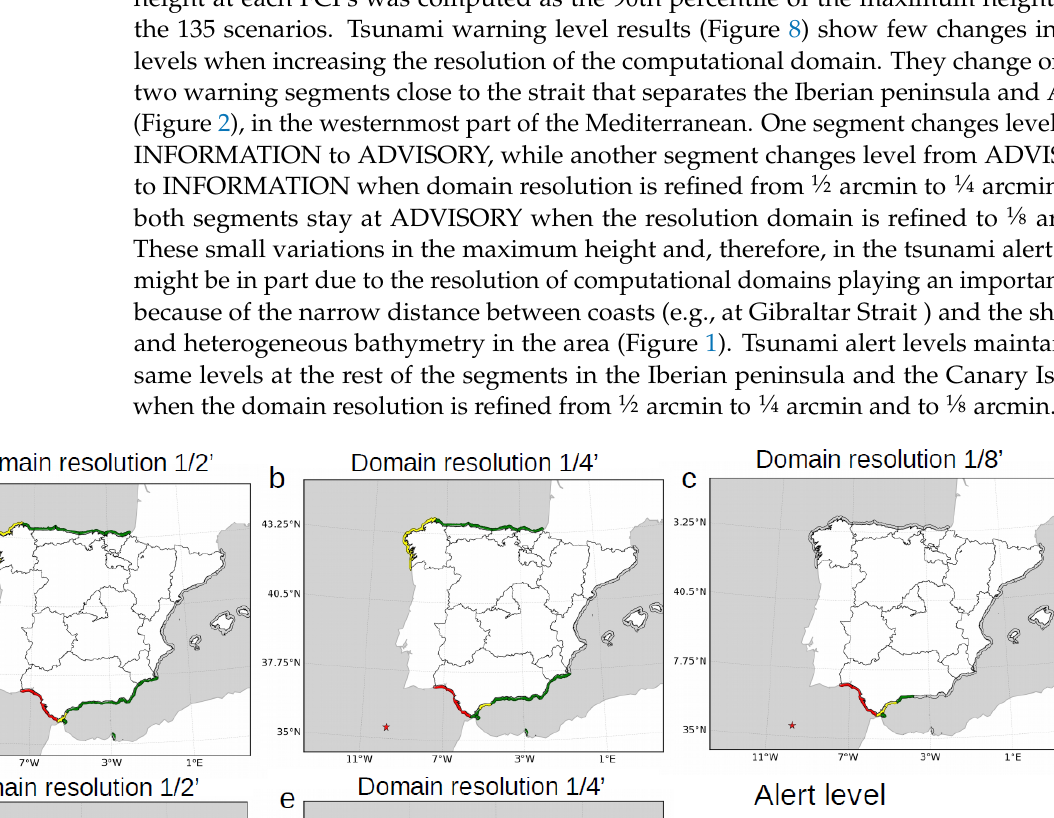
Table 2. Comparison of operational parameters at the National Tsunami Warning System of Spain for tsunamis generated in the Gulf of Cadiz and at the ChEESE live demo.